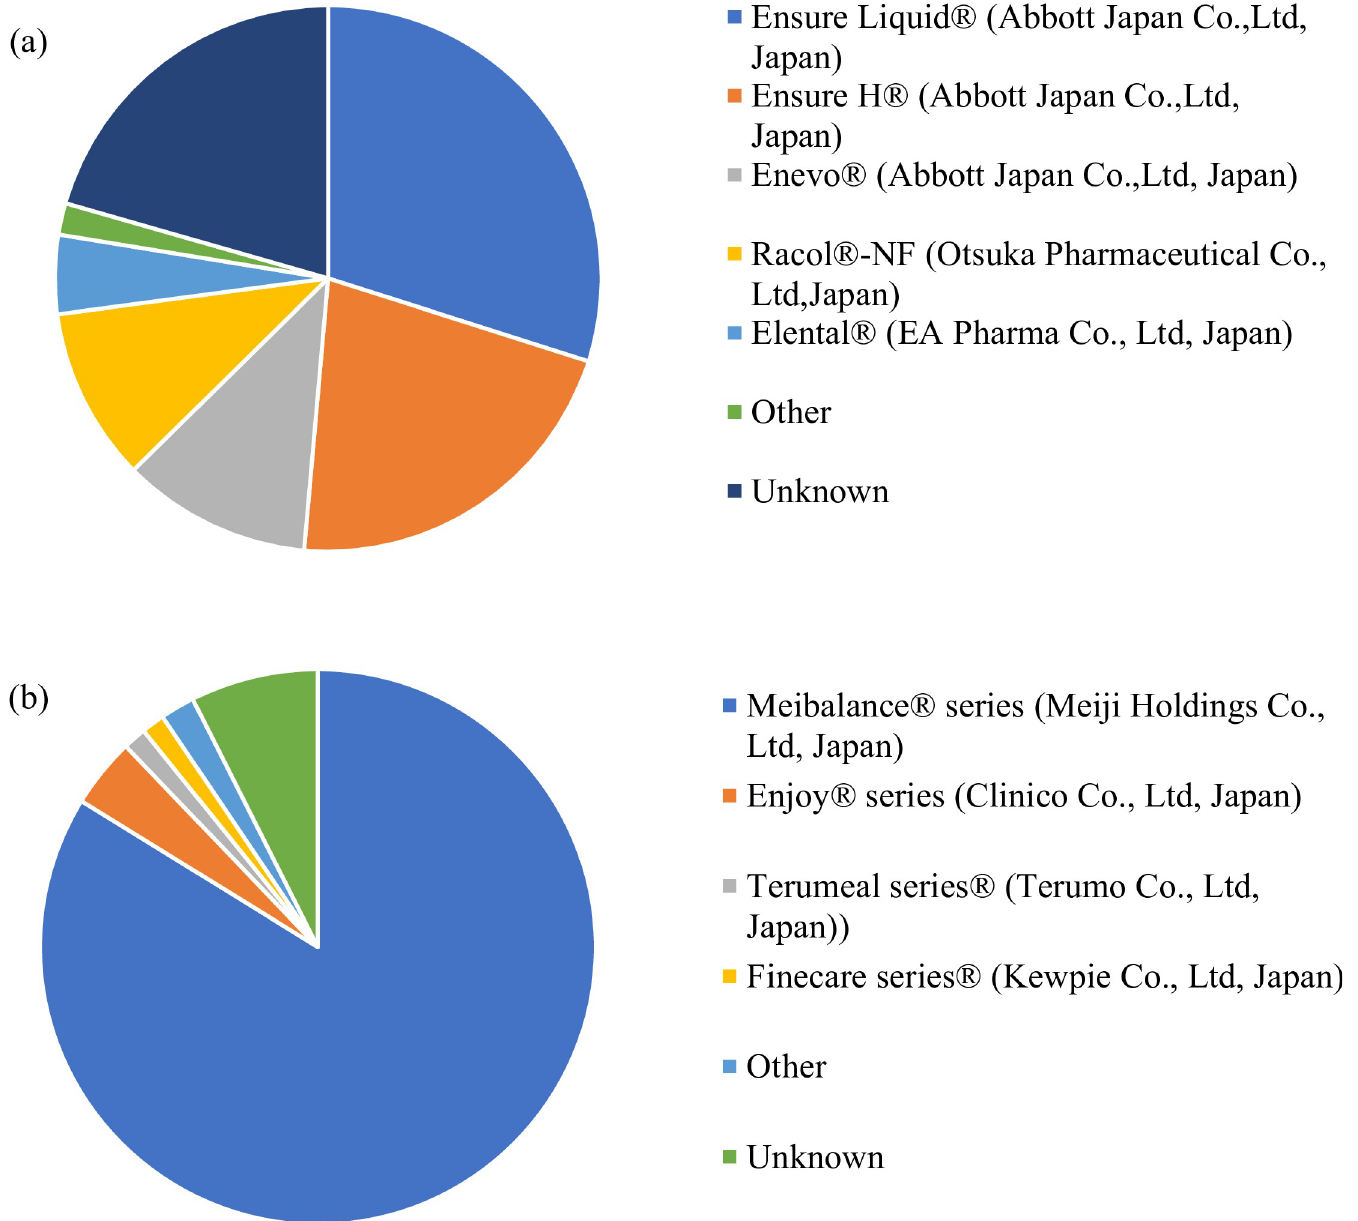
Fig 2. ONS types: (a) prescription ONS (n = 107). (b) over-the-counter ONS (n =